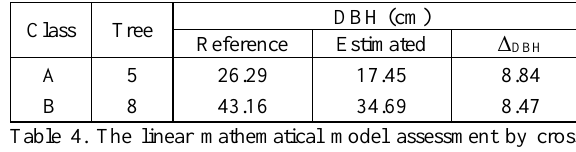
Table 2. Precision (Std) and the adjusted coefficient of multiple determination (R² adj) resulting from the stepwise method for class A and class B.